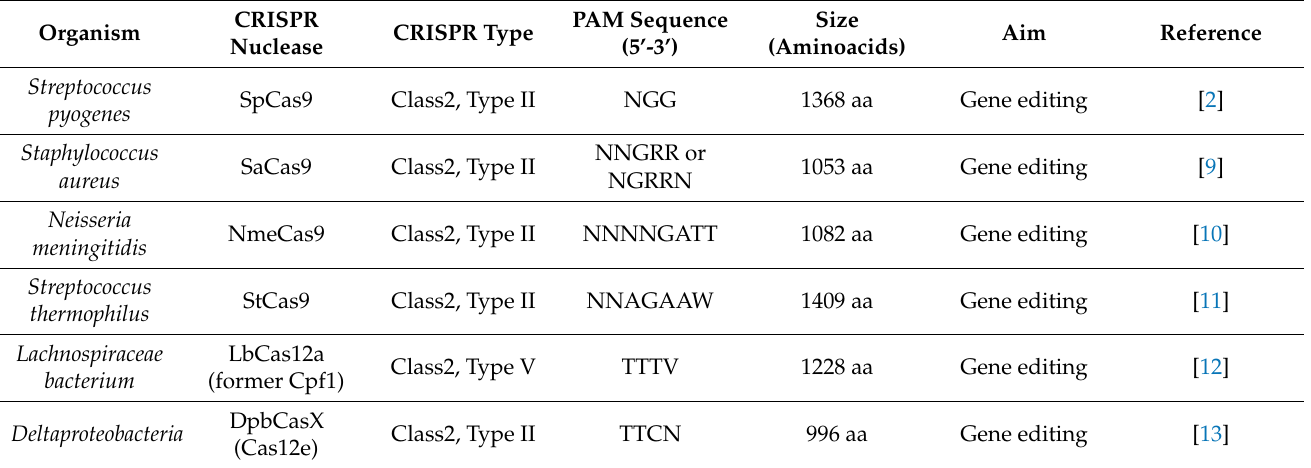
Table 1. Class2 Cas nucleases